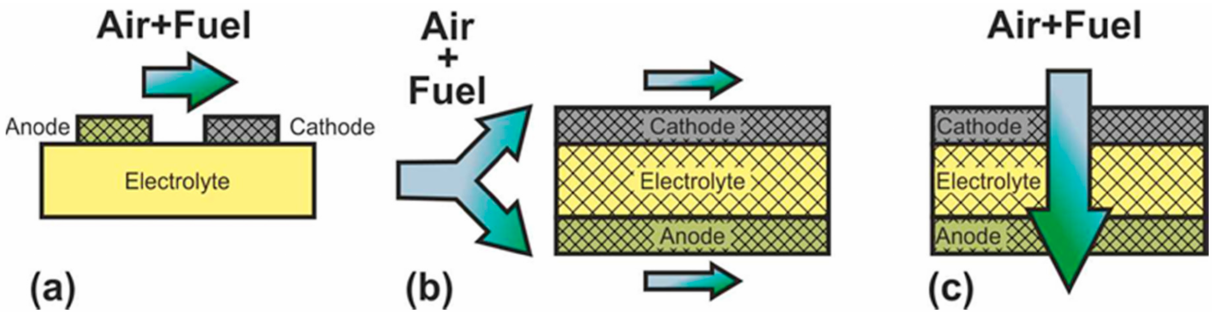
Figure 3. Schematics of ( a ) SC-SOFC with coplanar electrodes and fully porous SOFC in ( b ) flow-by and ( c ) flow-through